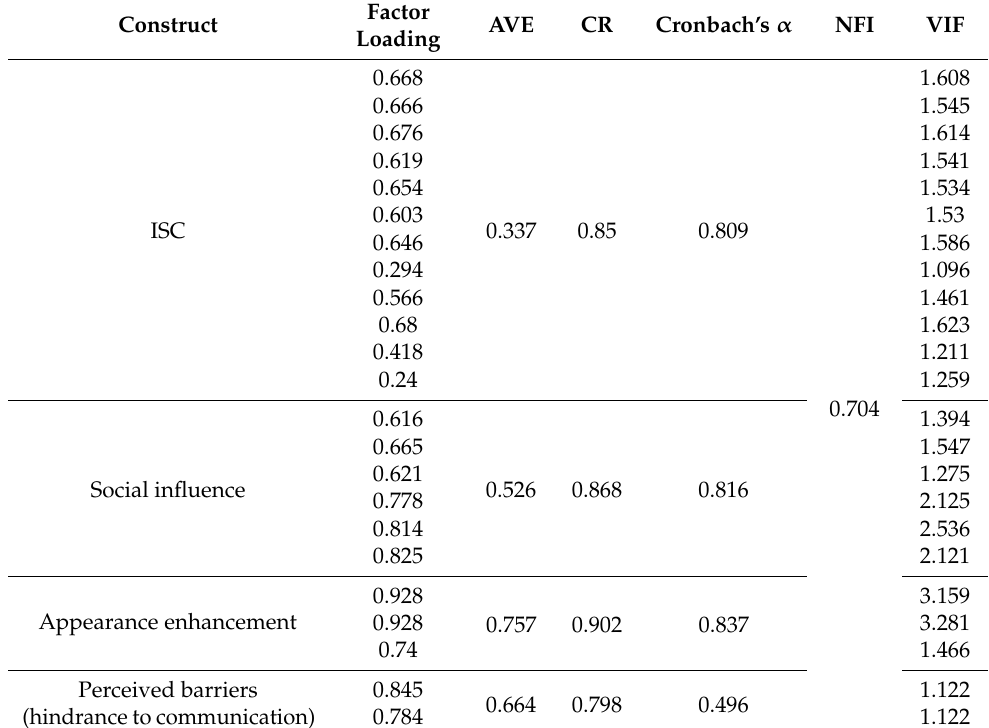
Table 1. Convergent validity, reliability, VIF and NFI